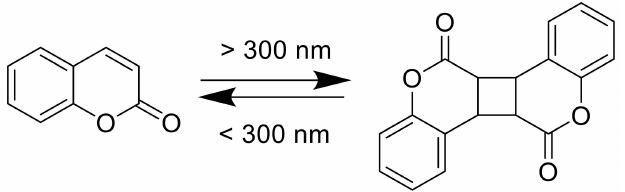
Figure 2. Photodimerization of